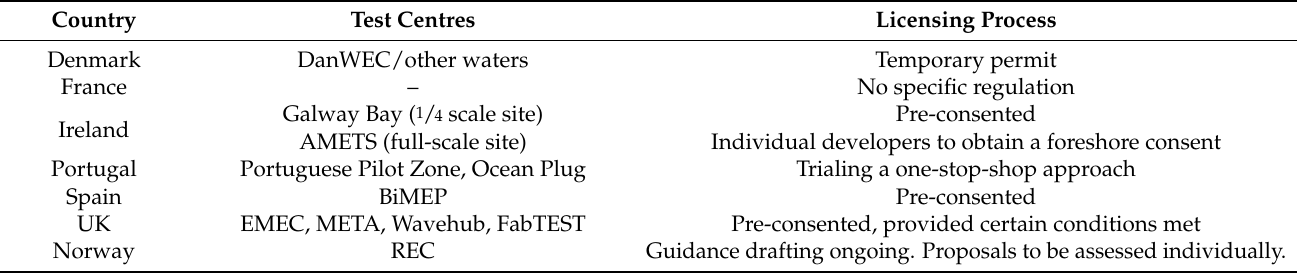
Table 3. Licensing procedure in test centres.